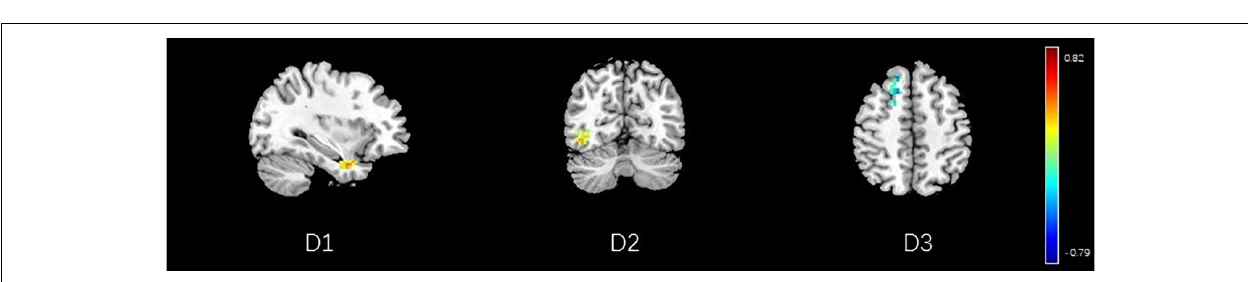
FIGURE 15 | Regions showing significant correlation with the pain score of nocebo response in male participants. Color scale represents the correlation coefficient. Red = positive correlation; blue = negative correlation. D1: temporal pole, D2: inferior temporal lobe, D3: dorsolateral prefrontal